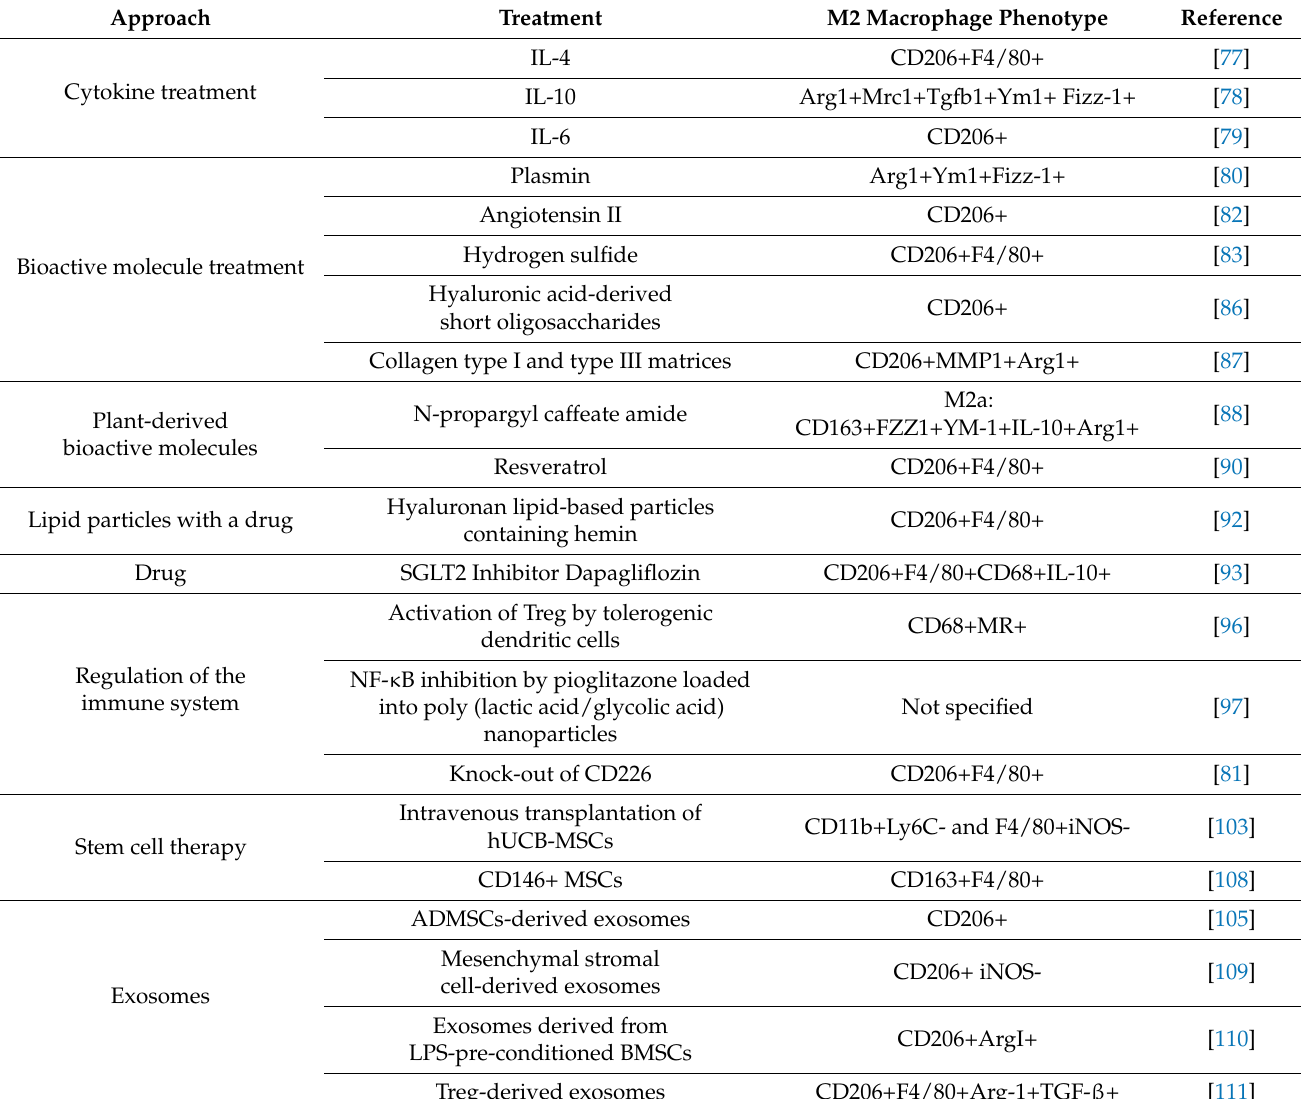
Table 1. Approaches that are used to enhance M2 polarization in MI